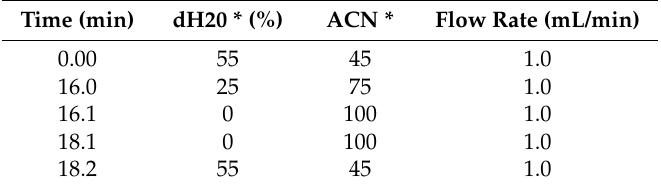
Table 2. LC-MS/MS Gradient Conditions for Elution of CRV431 and Metabolites. Time